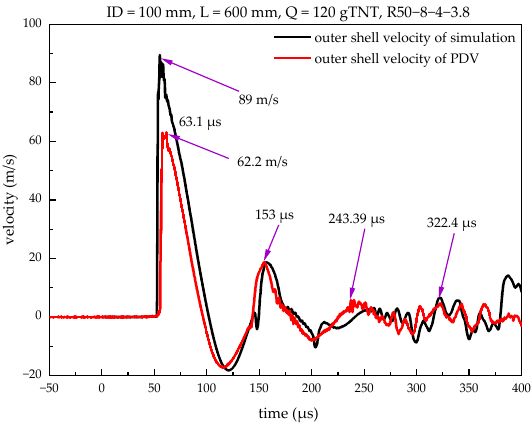
Figure 17. Velocities of PDV measurement and simulation.